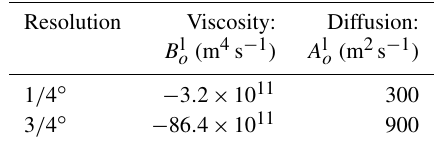
Table 1. Horizontal eddy viscosity and diffusivity values at the